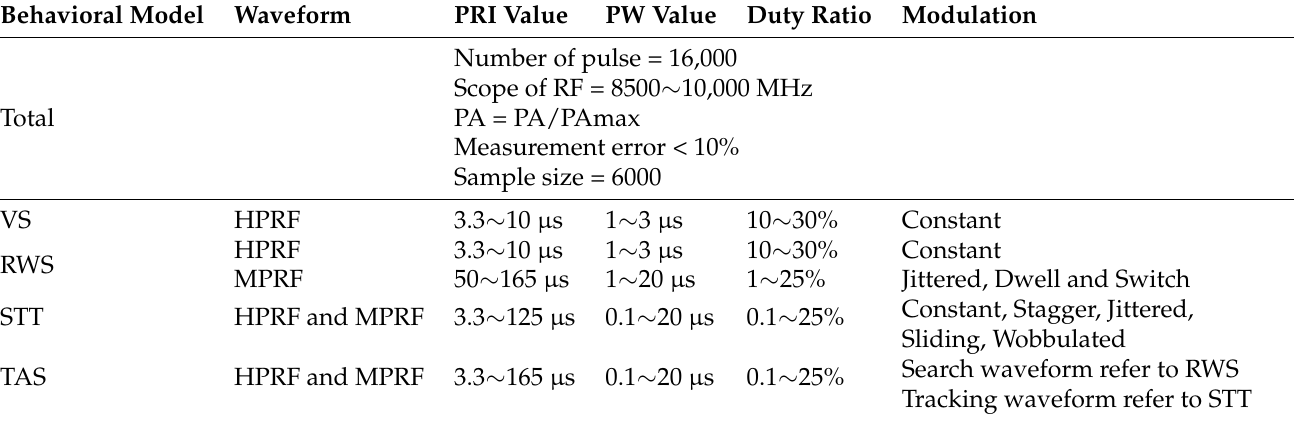
Table 3. RPDWS-II dataset. Each behavior pattern sample is randomly combined from a given range. It should be noted that the test set is generated completely independent of the training set verification set, rather than being divided in the same set of data, to simulate the mismatch between the training set and the test